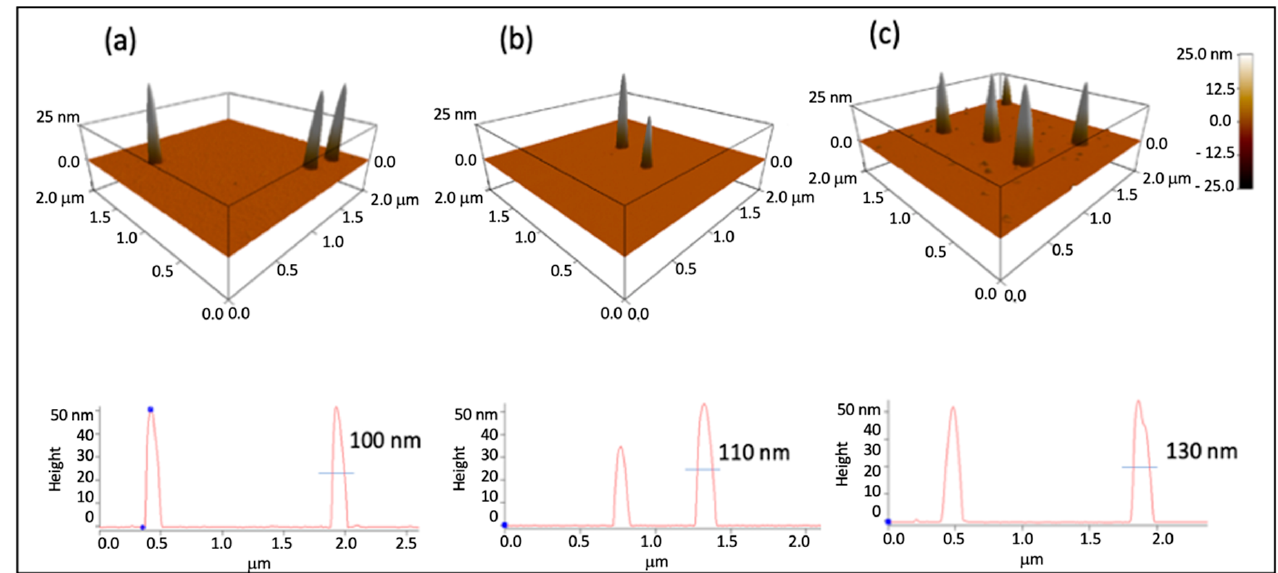
Figure 6. AFM 3D topography images, recorded in AC mode in air, for a PNP ( a ), a loaded-PNP ( b ) and a grafted-PNP ( c ) with the corresponding line-section curves.